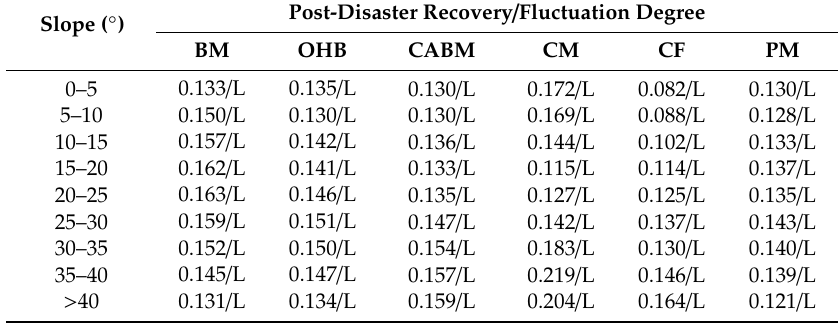
Table 15. Post-disaster recovery and fluctuation-degree-analysis results for six forest types in di ff erent slope